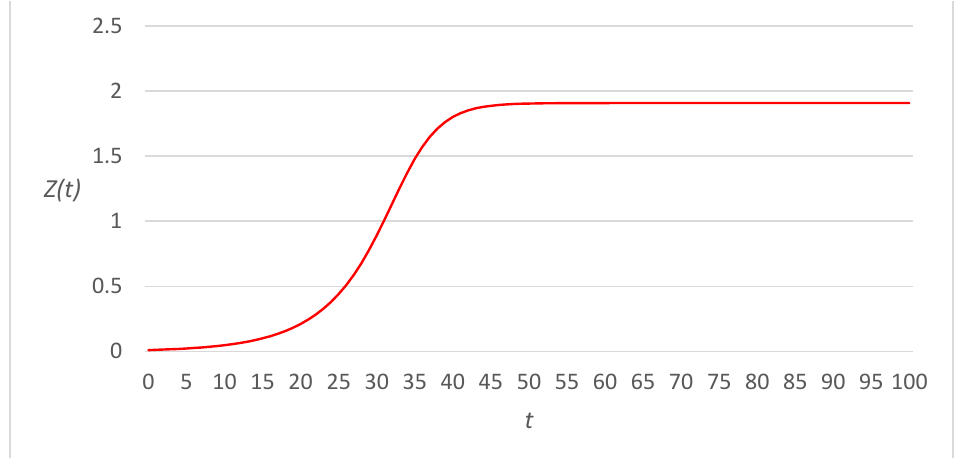
Figure 12. Time evolution of dynamical system for α = 0.5; β = 0.5; γµ = 10; ϕ = 0.8; Z ( 0 ) = 0.01 (case of fourth-power link cost functions).